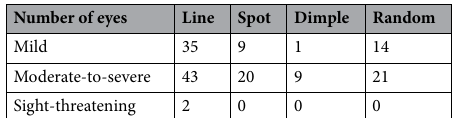
Table 3. Ratio of tear film break-up patterns among severity of thyroid eye